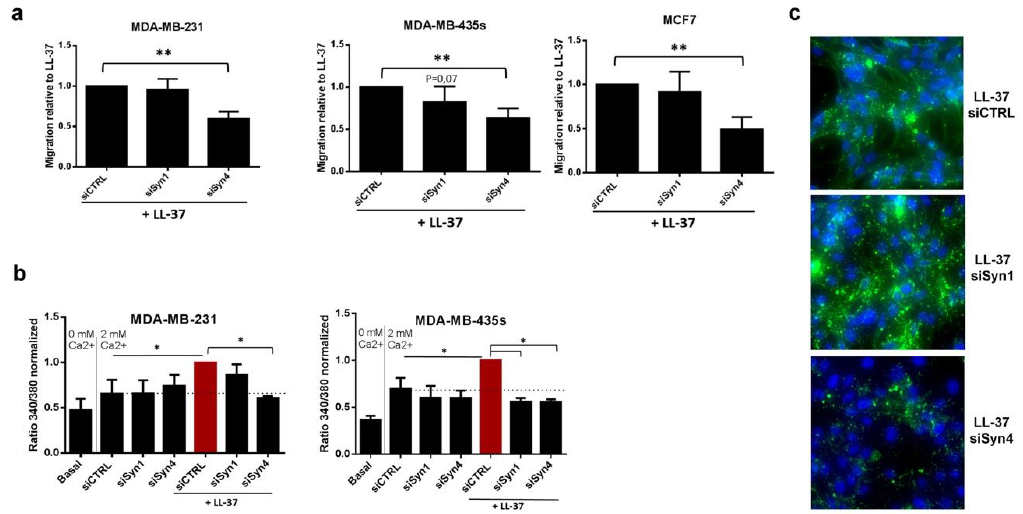
Figure 4. Syndecan-4 is implicated in LL-37 induced-calcium entry and cell migration. E ff ects of RNA interference against syndecan-1 and 4 on ( a ) LL-37-induced migration of MDA-MB-231, MDA-MB-435s and MCF7 (N = 5). ( b ) Calcium entry in MDA-MB-231, MDA-MB-435s cell lines induced by LL-37 (N = 3). ( c ) Immunofluorescence labeling with anti-LL-37 (Alexa488-green) on MDA-MB-231, treated with siRNA against syndecans-1 and 4. Nuclei labeled by DAPI (in blue). Magnification 400x. Data are normalized to the e ff ects of LL-37. Statistics: ** p < 0.01, * p < 0.05.